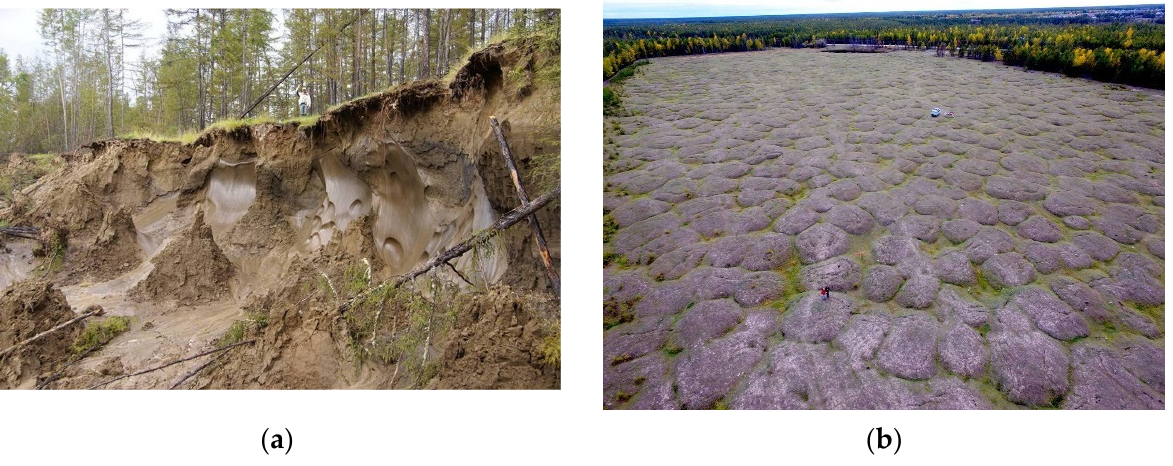
Figure 4. Ice-wedge exposure ( a ) and abandoned arable land from thermokarst development in the ice-rich permafrost ( b ) near the Syrdakh settlement in central Yakutia. The change in soil and vegetation cover determines the dynamic state of the permafrost in the context of global